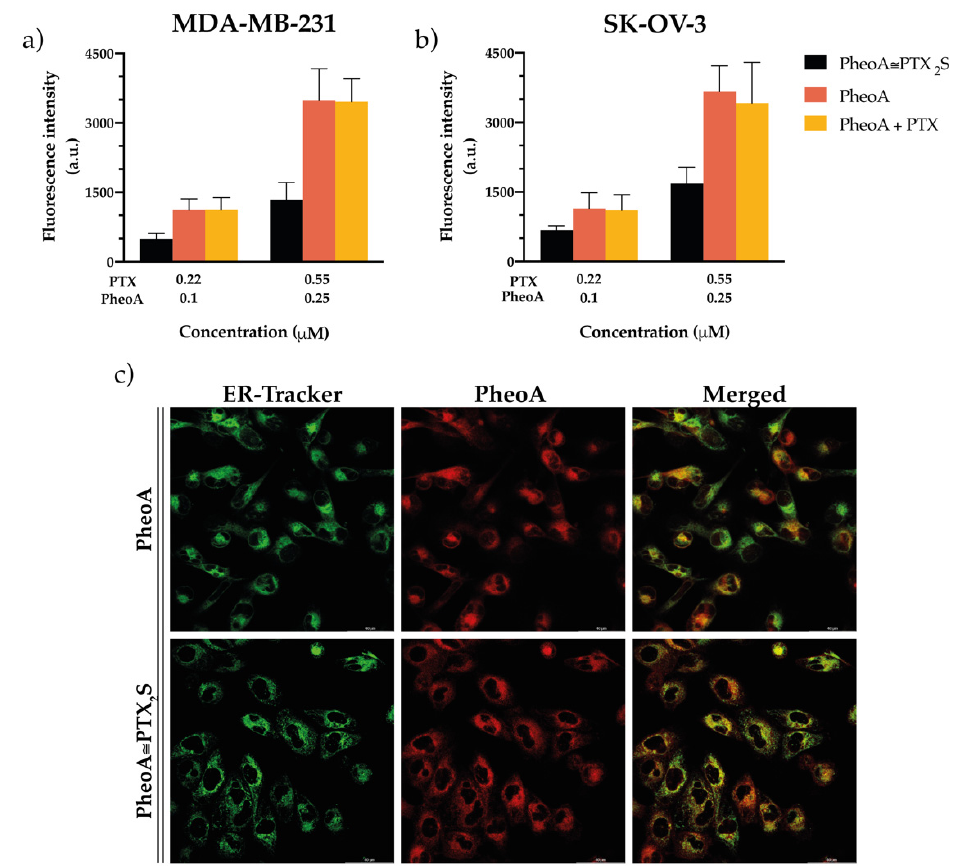
Figure 6. In vitro uptake and intracellular localization studies. Flow cytometry measurements of the intracellular uptake of PheoA delivered in the different formulations in ( a ) MDA-MB-231 and ( b ) SK-OV-3 cells exposed to the treatments for 4 h. Data are expressed as mean percentage ± SD of at least three independent experiments, carried out in triplicate. ( c ) Confocal microscopy images of MDA-MB-231 cells showing the co-localization between the red fluorescence of PheoA (delivered in the standard solvent or loaded in PheoA ≅ PTX 2 S) and the green fluorescence of ER-Tracker used as a specific probe for endoplasmic reticulum. Scale bars: 40 μ m.